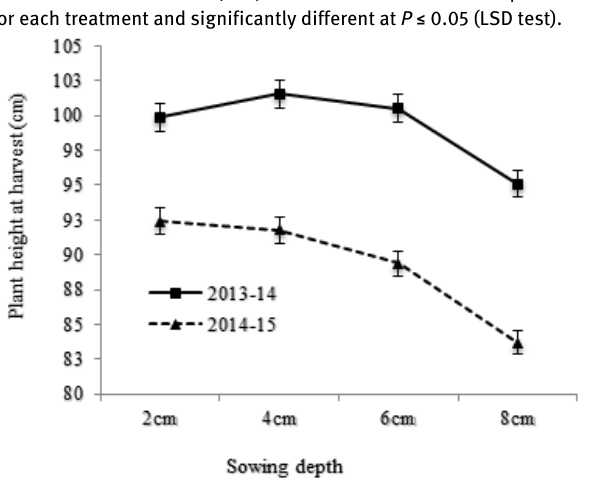
Figure 7: Plant height at harvest as affected by sowing depth of wheat. Mean (±SD) was calculated from three replicates for each treatment and significantly different at P ≤ 0.05 (LSD test).